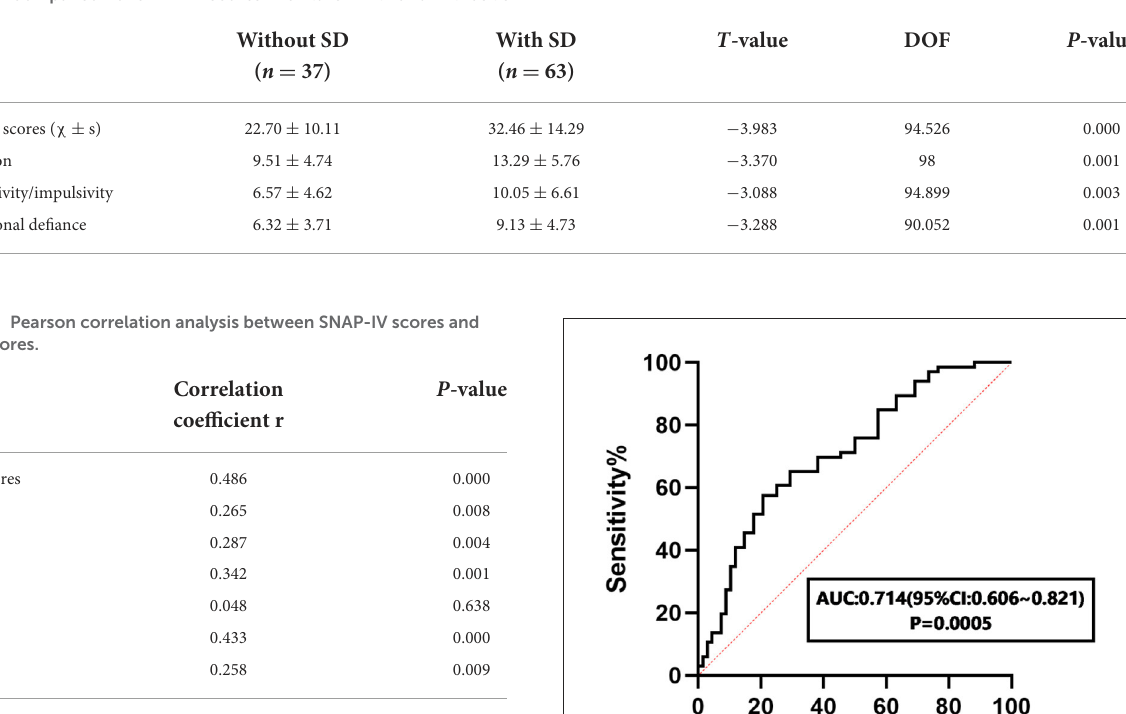
TABLE 3 Comparison of SNAP-IV scores in children with and without SD.